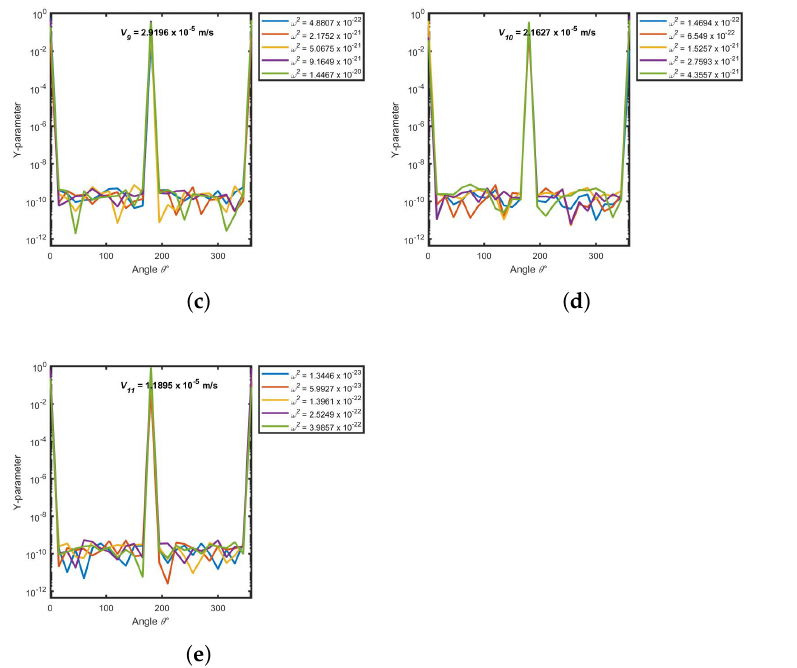
Figure A2. Y- parameter ( Y p ) as a function of angle ( θ ) for channel thickness h = 1.7 × 10 − 5 m, time t = 10 d and varying separation constant ( ω 2 ) . These results correspond to the second half- wing of those presented in Figure 6. ( a ) v 7 = 3.7846 × 10 − 5 m/s, ( b ) v 8 = 3.4602 × 10 − 5 m/s ( c ) v 9 = 2.9196 × 10 − 5 m/s ( d ) v 10 = 2.1627 × 10 − 5 m/s and ( e ) v 11 = 1.1895 × 10 − 5 m/s.